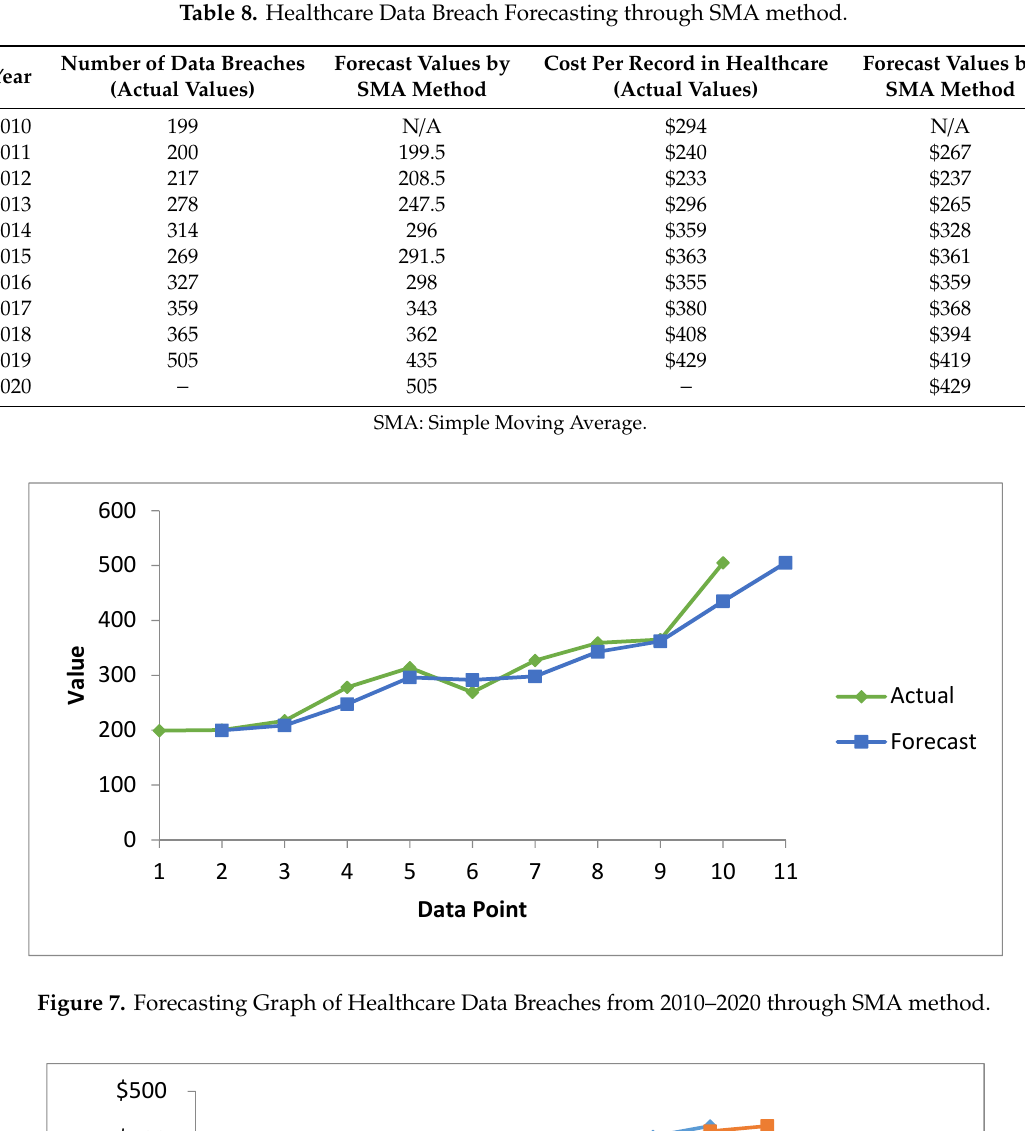
Table 8. Healthcare Data Breach Forecasting through SMA method.